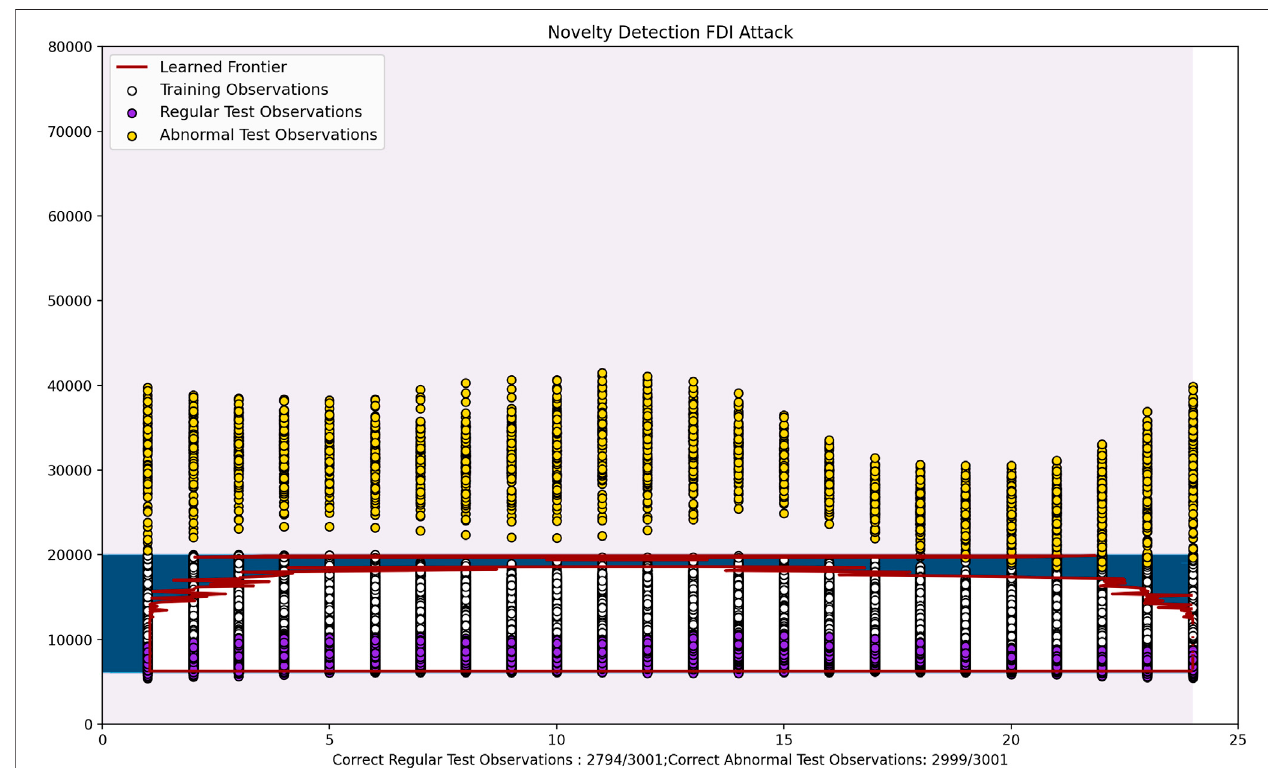
FIGURE 13 | OC-SVM on second